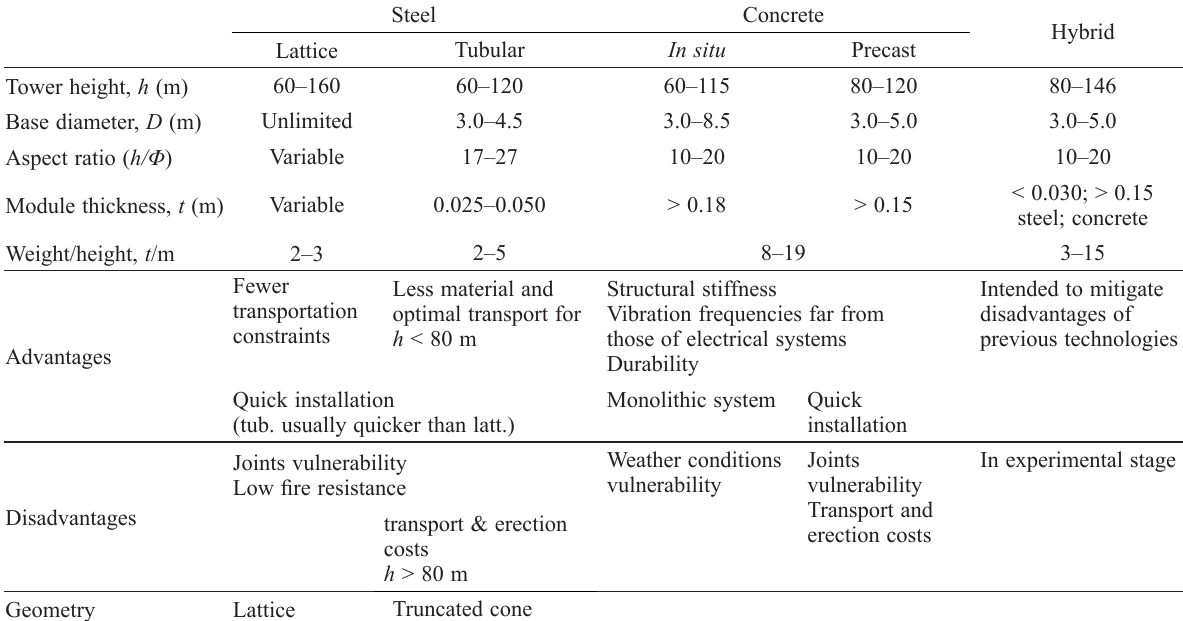
Table 1. Applications, advantages, and disadvantages of current tower